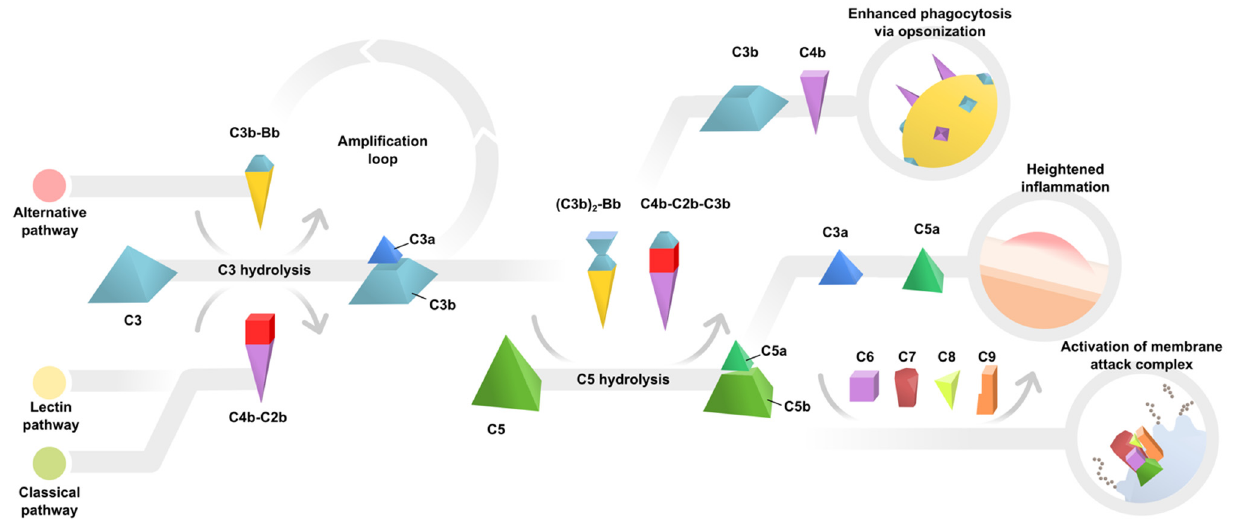
Figure 1. Schematic detailing key effectors of the complement